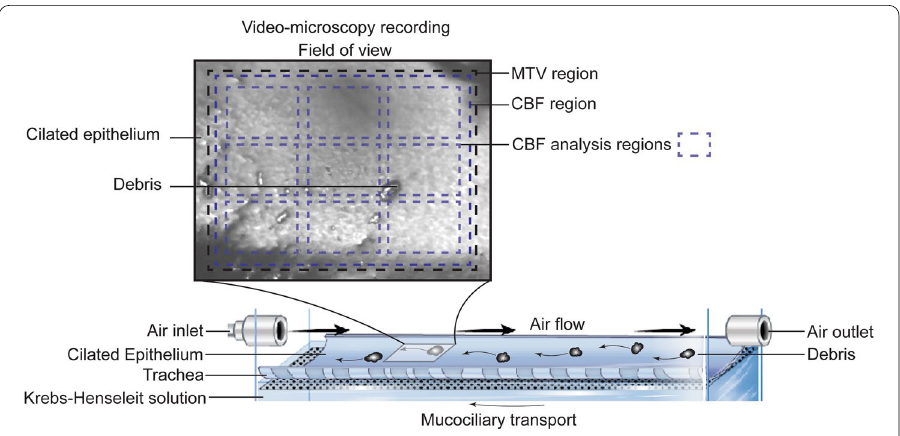
Fig. 2 Field of view from video-microscopy recordings and the analysis region for the mucus transport velocity (MTV) and cilia beat frequency (CBF) with the 3-by-3 gridded subset of regions for more detailed analysis. Arrows indicate the direction of air-flow and mucociliary